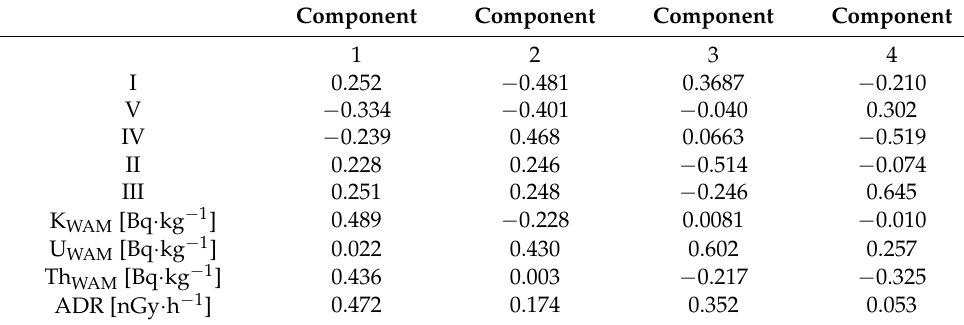
Table 5. Table of Component